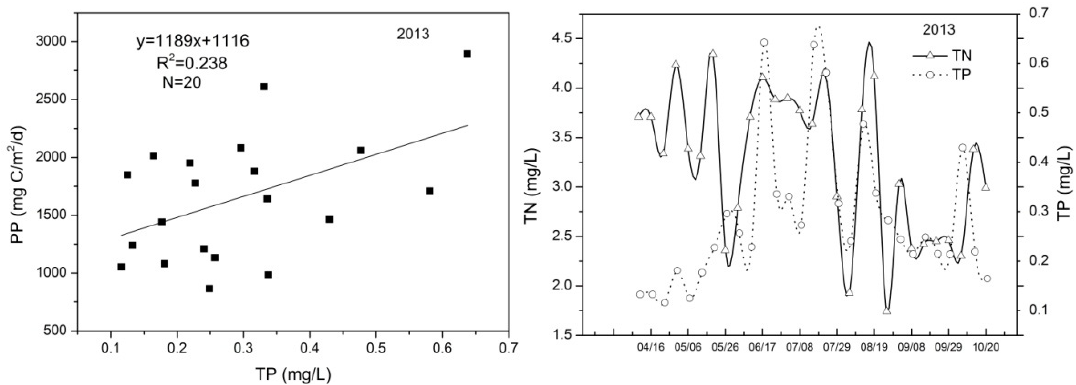
Figure 10. Time series of total nitrogen and total phosphorusin 2013, and the correlation between phytoplankton primary production and total phosphorus.